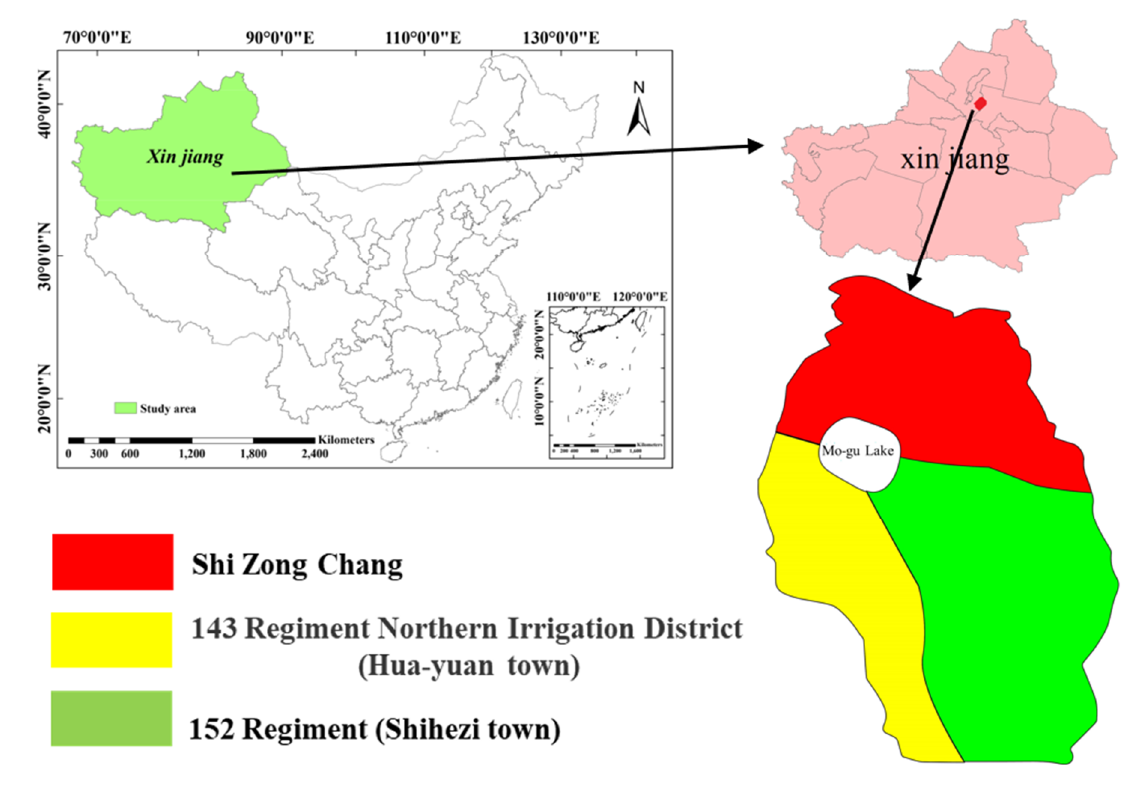
Figure 2. Diagram of the Shihezi Irrigation Area.